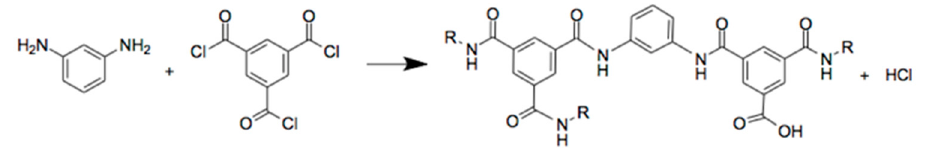
Figure 2. Polycondensation reaction between m-phenylenediamine (MPD) and trimesoylchloride (TMC) with the formation of polyamide (PA).